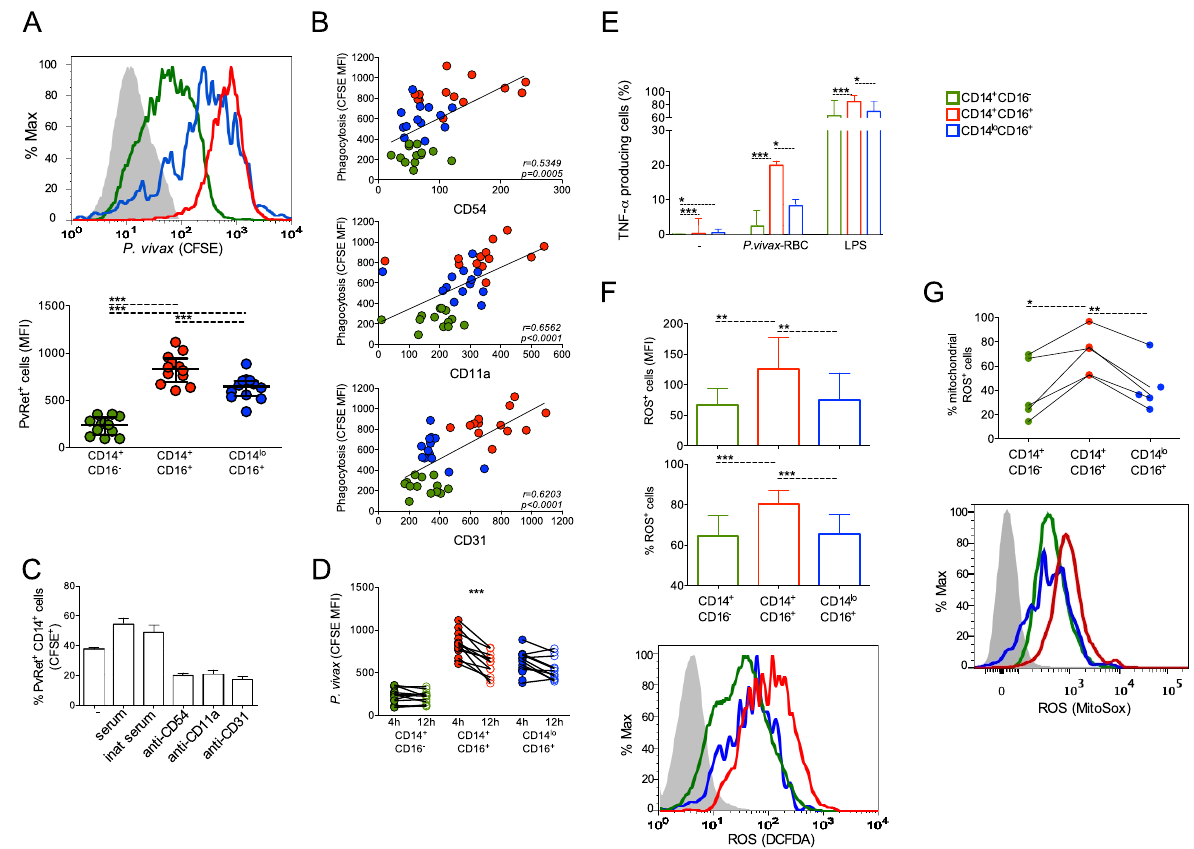
Figure 7. CD16 + CD14 + monocytes display pronounced phagocytic ability than other subsets. CD14 + CD16 2 , CD14 + CD16 + and CD14 lo CD16 + monocytes are represented by green, red, and blue symbols, respectively. P. vivax -infected reticulocytes (Pv-Ret) were purified, CFSE labeled (A, B, C) or not (D, E) and cultured with PBMC from acutely P. vivax -infected subjects. (A) Mean fluorescence intensity (MFI) of CFSE within CD14 + CD16 2 , CD14 + CD16 + , CD14 lo CD16 + monocytes exposed to P. vivax was measured by flow cytometry after 4 hours of culture. Each circle represents a single patient (n=12) and lines represent median values and interquartile ranges (B) Correlation between P. vivax phagocytosis (CFSE MFI) and CD54, CD11a or CD31 expression by CD14 + CD16 2 , CD14 + CD16 + , CD14 lo CD16 + monocytes. Circles indicate individual patients (n=13). (C) Phagocytosis of Pv-Ret by CD14 + cells was measured in the absence of serum, presence of inactivated serum and presence of serum, and in the presence of anti-CD54, CD11a and CD31 blocking antibodies (lower graph). Bars represent median values and interquartile ranges (n=6). (D) MFI of CFSE within CD14 + CD16 2 , CD14 + CD16 + , CD14 lo CD16 + monocytes exposed to P. vivax was measured by flow cytometry after 4 and 12 hours of culture. Connecting circles represent values of CFSE MFI of a single patient after 4 and 12 hours of culture, (n=12) (E) Frequencies of TNF- a producing monocyte subsets were measured after culture with medium alone, Pv-Ret or LPS. Bars represent median values and interquartile ranges (n=6). (F) ROS production was detected by measuring MFI (top panel) and the proportions (middle panel) of carboxy-H 2 DCDA + CD14 + CD16 2 , CD14 + CD16 + and CD14 lo CD16 + monocytes after 3 hours incubation with P. vivax -infected reticulocytes. Bars represent median values and interquartile ranges (n=9). Representative histograms showing MFI of carboxy-H 2 DCFDA expressing CD14 + CD16 2 , CD14 + CD16 + , CD14 lo CD16 + monocytes (bottom panel). Grey histogram represents CD14 + cells cultured in the absence of Pv-Ret. (G) Mitochondrial ROS was assessed in monocyte subsets from P. vivax -infected patients measuring MitoSox by flow cytomery after culture with P. vivax -infected reticulocytes (n=4). Connecting circles represent frequencies of different monocyte subsets producing mitochondrial ROS. Symbols represent individual subject. Representative histograms showing MFI of MitoSox expressing CD14 + CD16 2 , CD14 + CD16 + , CD14 lo CD16 + monocytes (bottom panel). Grey histogram represents MitoSox- cells. * p , 0.05, **0.05 . p . 0.01, *** p , 0.01.